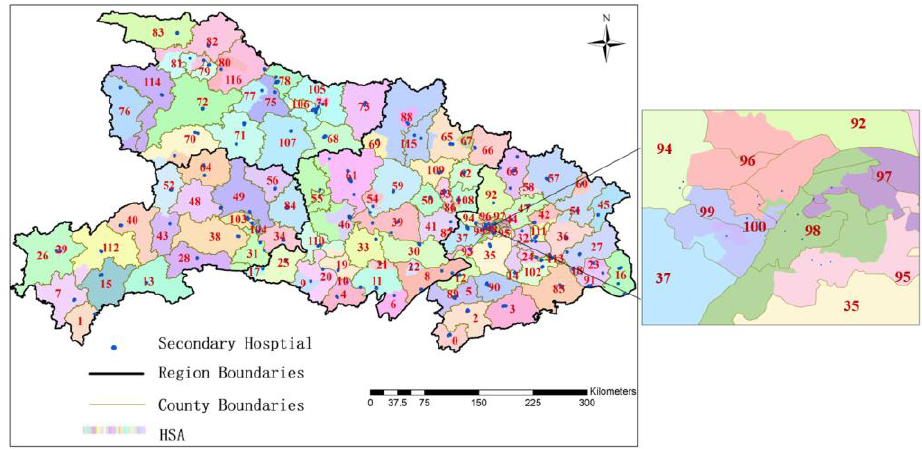
Table 1. Statistics of HSAs in four regions.